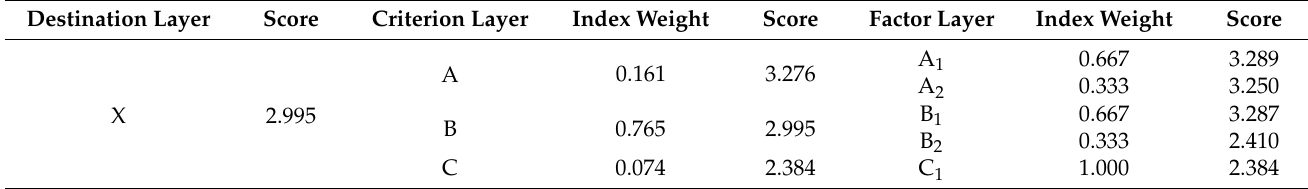
Table 3. The scores for the factor layer, criterion layer, and destination layer.